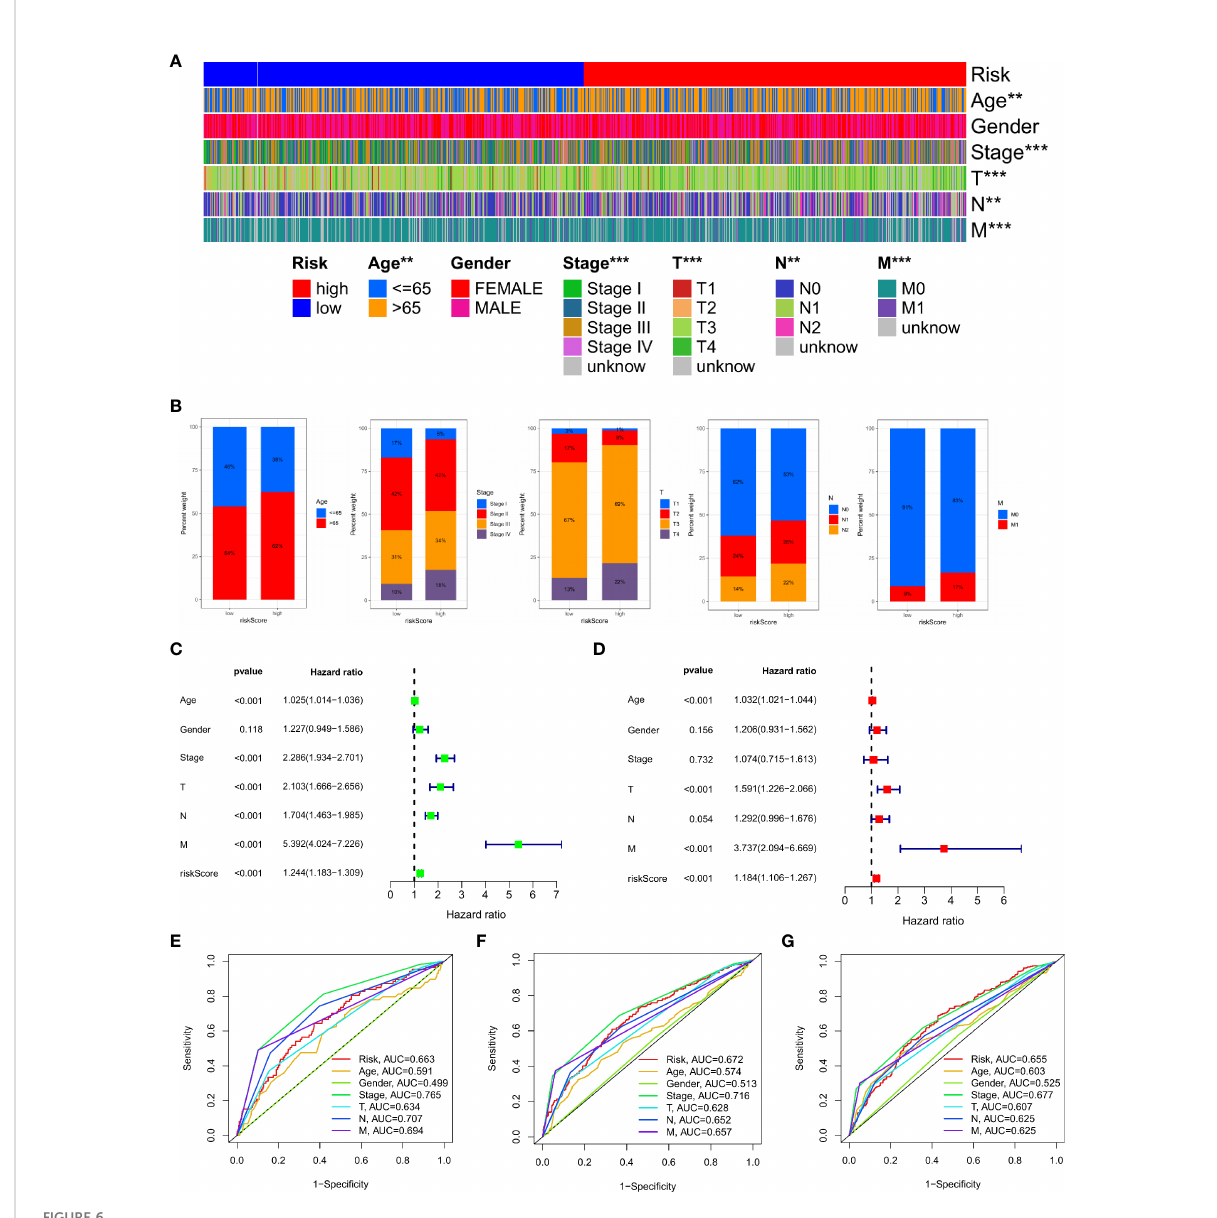
FIGURE 6 Clinical application value and independent prognostic analysis. (A) Heat map of the correlation between high and low risk scores and clinicopathological characteristics; (B) The proportion of high and low-risk scores to clinicopathological characteristics; (C) Univariate Cox regression analysis based on the IMRG risk score and clinicopathological characteristics; (D) Multivariate Cox regression analysis based on IMRG risk score and clinicopathological characteristics; (E – G) The ROC curve evaluates the predictive effect of the risk model at 1-, 3-, 5-year OS; ***p < 0.001; **p <